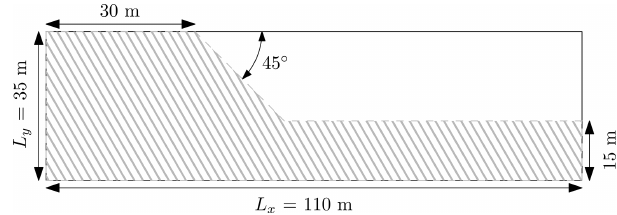
Figure 14. Initial geometry for the slump problem from Huang et al. (2015). Roller boundary conditions are imposed on the left and right of the domain, while a no-slip condition is enforced at the base of the material.